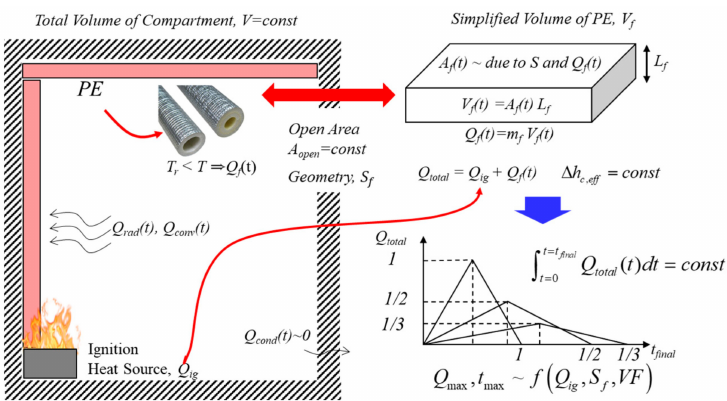
Figure 1. Schematic diagram of heat transfer and the heat release rate of the pipe insulation in a compartment